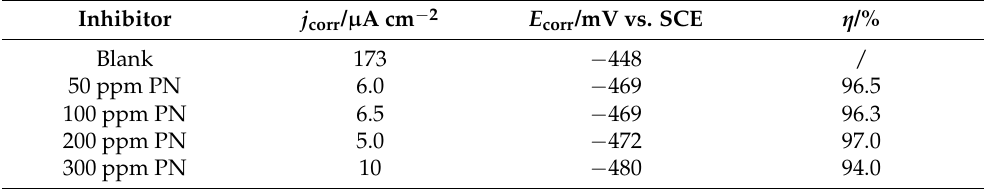
Table 3. Fitted parameters of the polarization Tafel plots for cold-rolled steel after 4 h immersion in 1 M